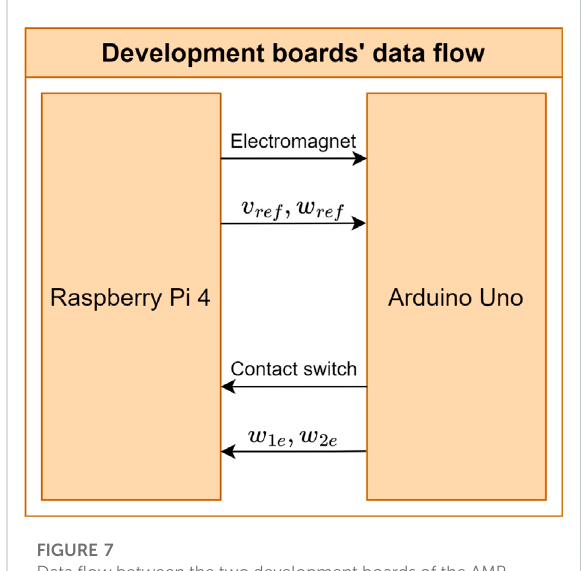
FIGURE 7 Data fl ow between the two development boards of the AMR.